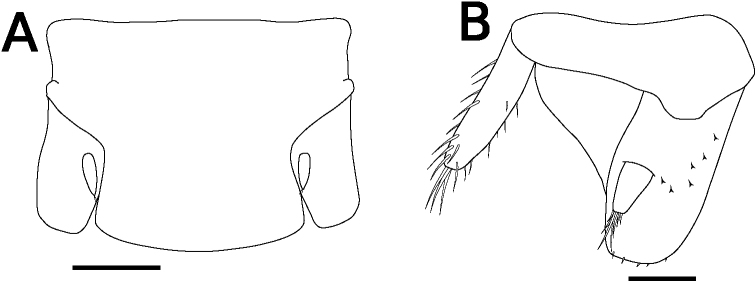
Sphaerillo
boninensisA pleotelson, holotype (male) B uropod, holotype (male). Scale bars: 200 μm (A); 100 μm (B).